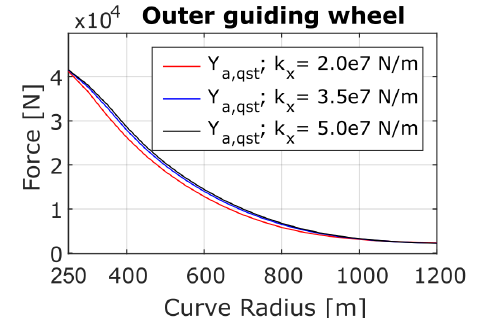
Figure 12. The difference T Figure 14. Depencence of the Y γ − T qst depending on a,qst on the curve the curve radius R (above) and the relative difference radius R in defined range of the longitudinal stiffness ( T γ − T qst ) /T γ depending on the curve radius R (be- of wheelset guiding k x per one low) for defined values of the bogie wheelbase 2 a .